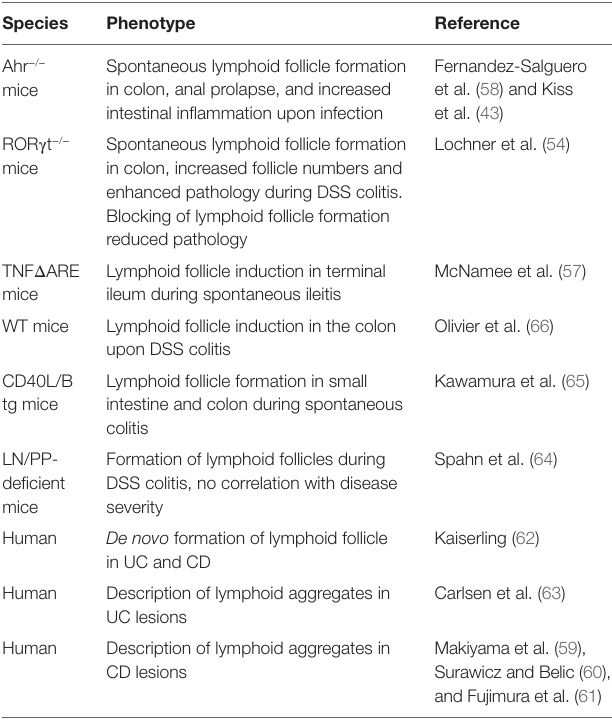
TABLe 1 | Formation of lymphoid follicles in intestinal